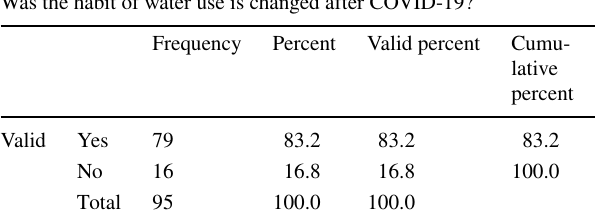
Table 3 The habit of water use changed after the COVID-19 pan- demic Was the habit of water use is changed after COVID-19?